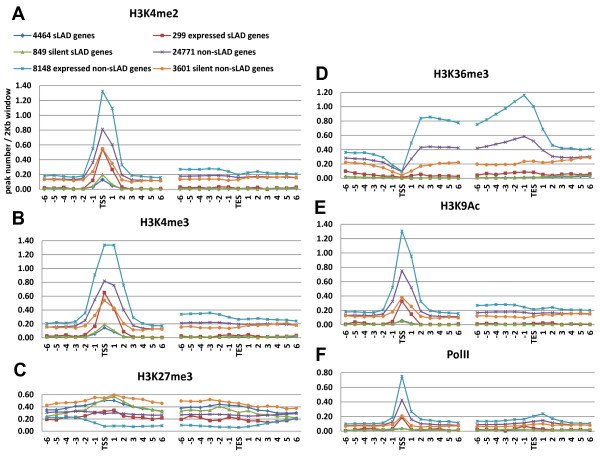
Distributions of histone modifications and Pol II across genic regions. ChIP-seq data are the same set as in Figure 6. For the six gene categories described in Figure 4A, peak density profiles of histone modifications were aligned using the 2 kb windows containing TSSs and TESs respectively, and the average peak densities (the peak number per 2kb window) of the six 2 kb windows upstream, the window containing TSSs/TESs, and the six 2 kb windows downstream were plotted: (A) H3K4me2, (B) H3K4me3, (C) H3K27me3, (D) H3K36me3, (E) H3K9Ac, (F) Pol II (8WG16). See Additional file 2: Figure S4 for plots of the other four histone modifications.